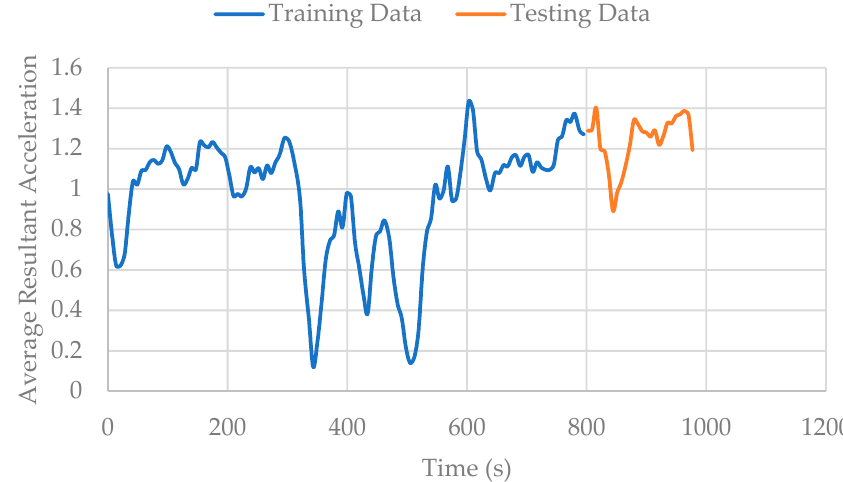
Figure 8. Information sharing at trip level.